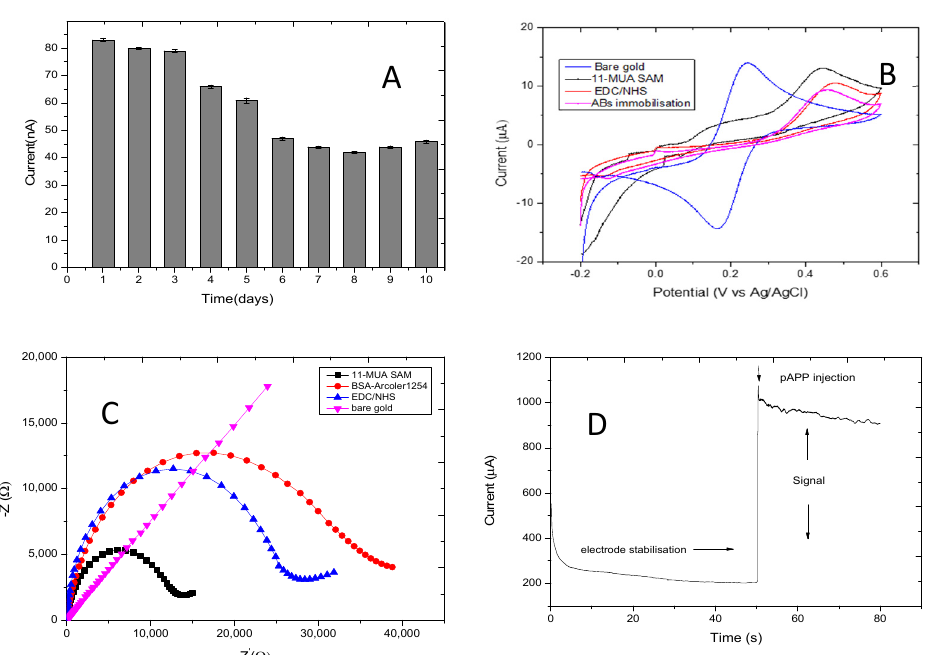
Figure 5. Electrochemical characterization of modified electrode. ( A ) A stability study of the coated BSA-Aroclor 1254 on a gold electrode surface was performed using linear sweep voltammetry. Prior to the measurements, the coated electrode was stored at 4 °C. Three electrodes were measured every day for 10 days. ( B ) The voltammogram of CV for the bare gold electrode and the gold electrode after SAM modification with 11-MUA. ( C ) Impedance spectra of the bare gold electrode, after 20 h SAM, activation with EDC/NHS and immobilization with 5 µg/mL − 1 BSA-Aroclor 1254. The redox couple was 5 Mm [Fe (CN) 6 ] 3 − /4 − in 0.1 KCl. Frequency measured from 0.1 Hz to 1 MHz, with amplitude of 0.1 V, potential applied at 0.21 V. The inserted circuit is Randle’s equivalent, where Rs represents the dynamic solution resistance, Rct represents the charge transfer resistance of the immobilize recognition layer, CdI indicates the capacitance measured between the gold electrode and the electrolyte solution on a double layer basis, and Zw is the Warburg element describing the time frequency. ( D ) Amperometric detection of a chip modified AP containing bilayer (competitive assay) was measured in DEA buffer pH 9.5 at potential of 0.45 V vs. Ag/AgCl. The substrate p APP was injected at 40 s.